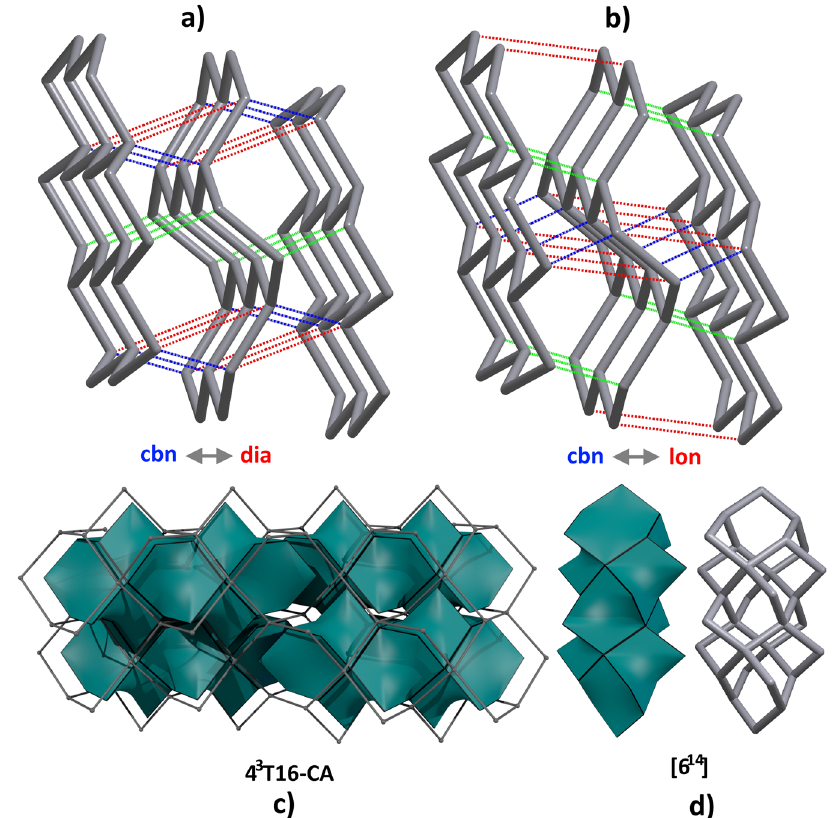
Fig. 1 Topological transformations. Transitions from M carbon ( cbn ) to a diamond ( dia ) and b lonsdaleite ( lon ) through common 4,4,5,5- coordinated supernets by creating red bonds in cbn and breaking blue bonds. The green bonds are preserved during the transition and correspond to topologically different common 3,3,4,4-coordinated subnets. Breaking these bonds results in the decomposition of the 3D structure into graphite sheets. The 4 3 T16-CA carbon allotrope: c network and the corresponding tiling and d the tile [6 14